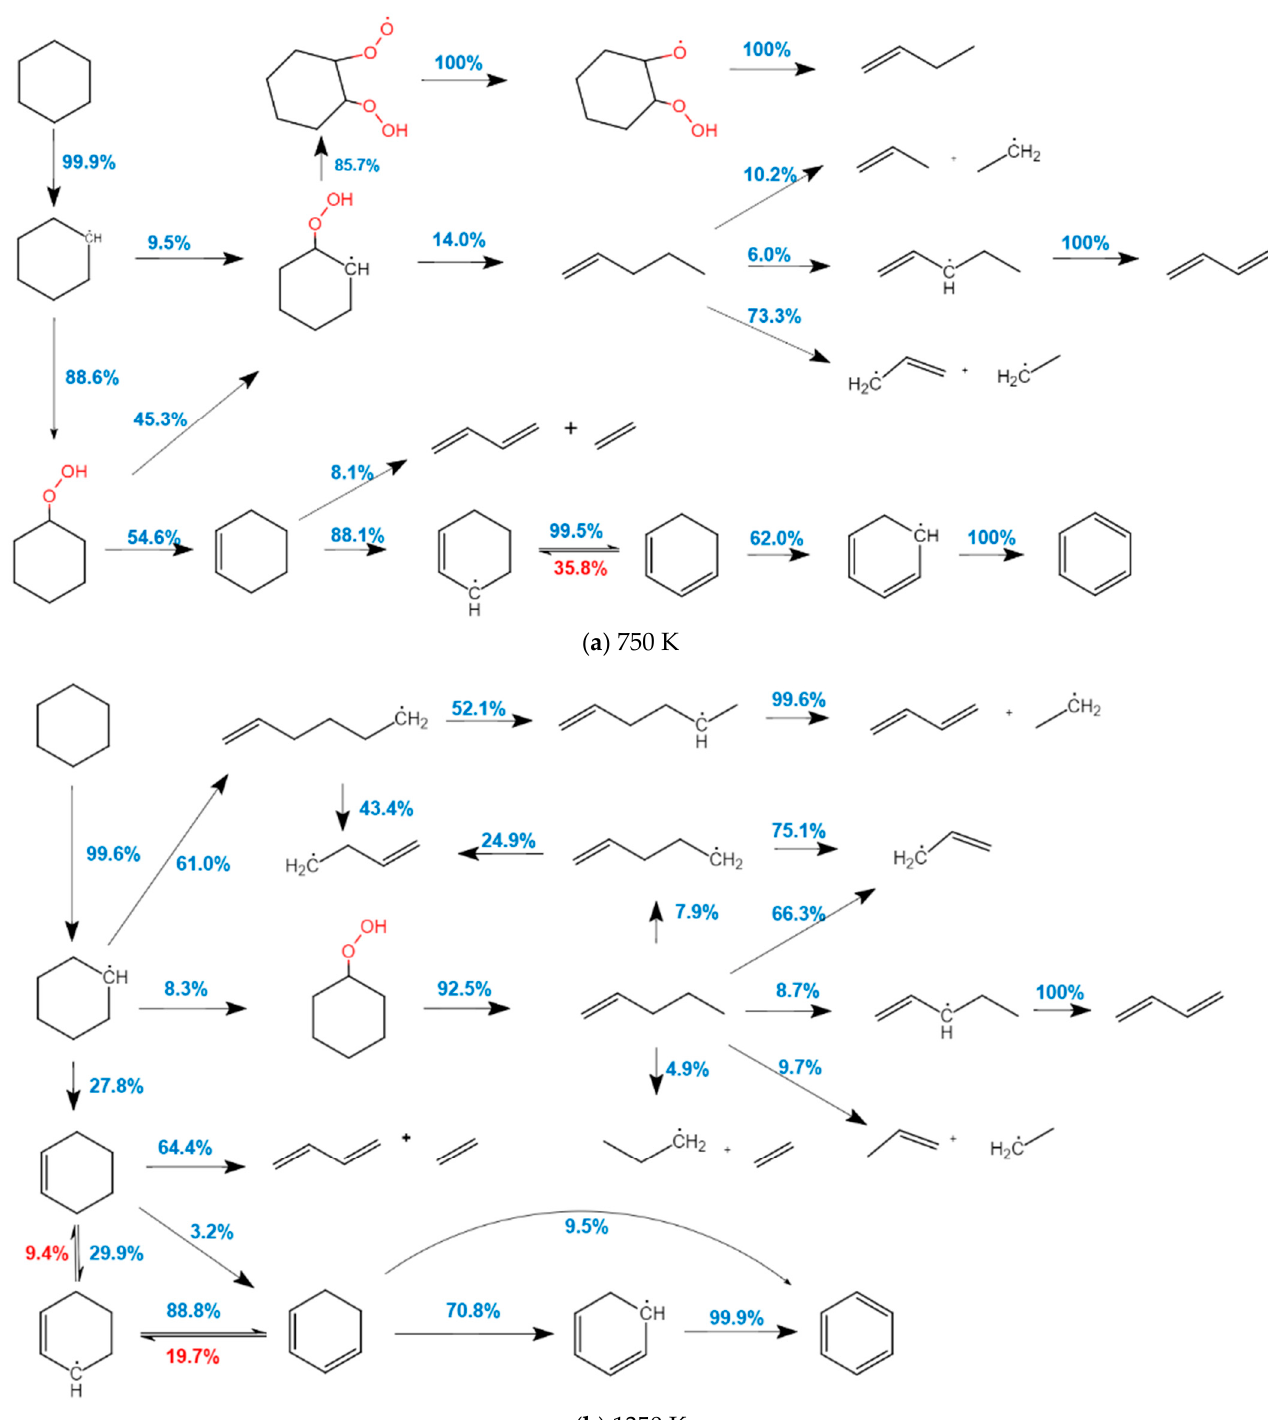
Figure 3. Main oxidation path of CHX. ( a ) 750 K and ( b ) 1350 K.